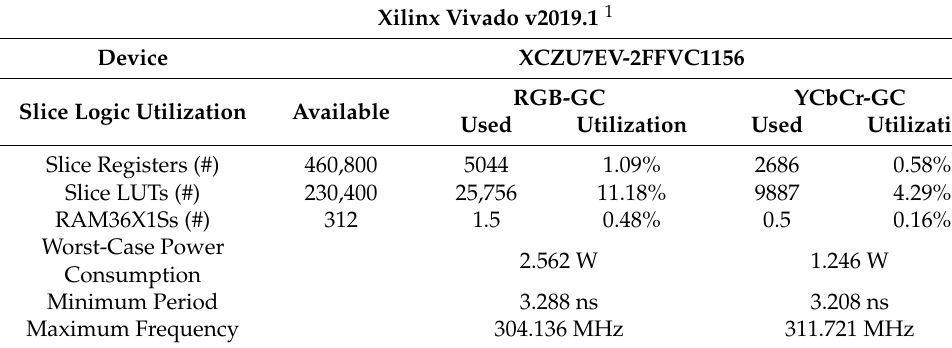
Figure 10. Two hardware designs for facilitating the integration of the proposed run-time recon- figurable gamma correction into existing real-time systems: ( a ) the first design that processes the red–green–blue image data separately (RGB-GC), and ( b ) the second design that performs color space conversion and processes the luminance (YCbCr-GC). Table 1. Implementation results of the proposed run-time reconfigurable gamma correction designs. The symbol # denotes